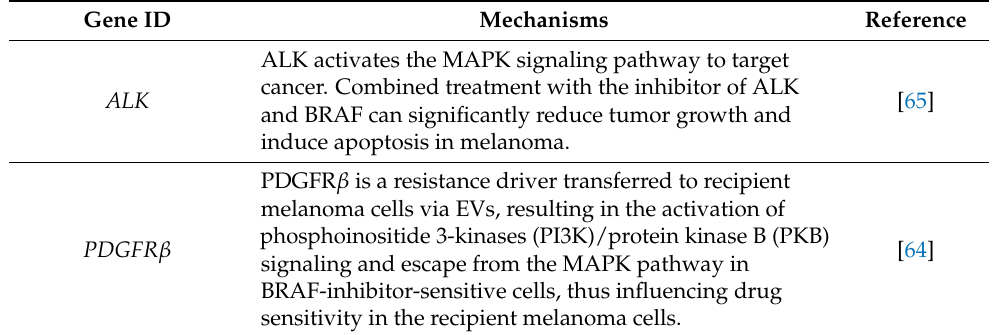
Table 3. The effect of tumor-derived EVs on drug